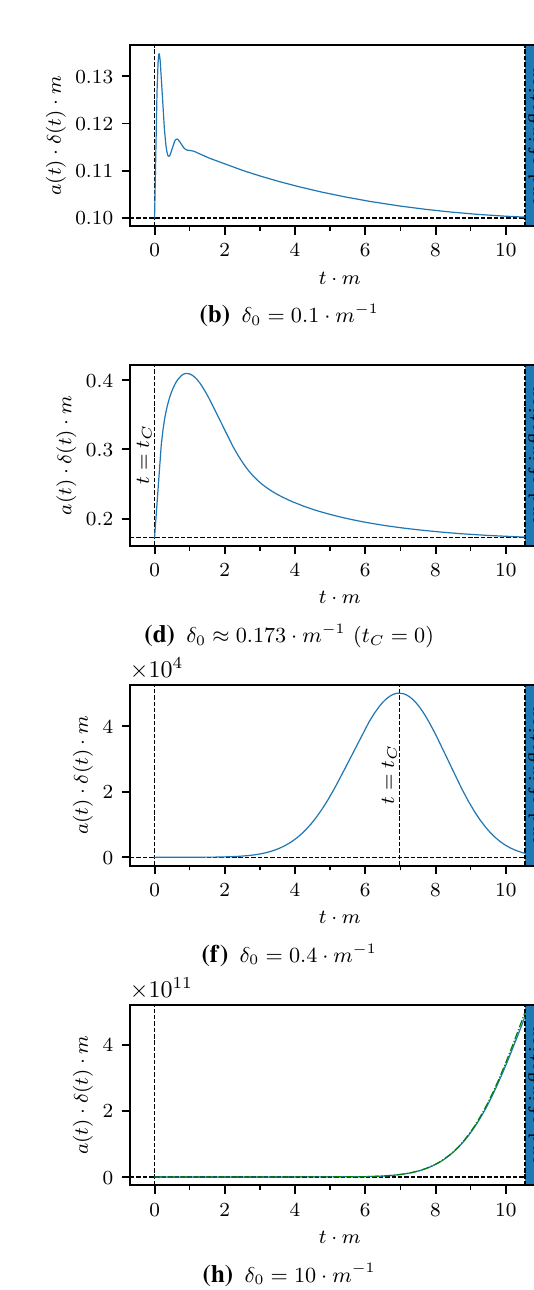
In Fig. 3d–f there is a vertical dashed line which corresponds to t = t C . In Fig. 3g, h there is a green (dash-dotted) line which corresponds to a ( t ) · δ 0 · m . In Fig. 3h this line coincides with a ( t ) · δ( t ) · m , which means that δ ( t ) ≈ δ 0 till the end of inflation with very good